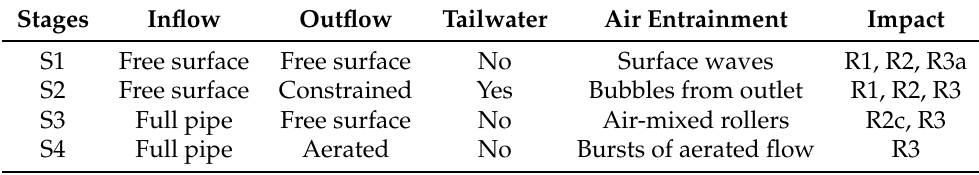
Table 1. Characteristics of the novel classification of flow